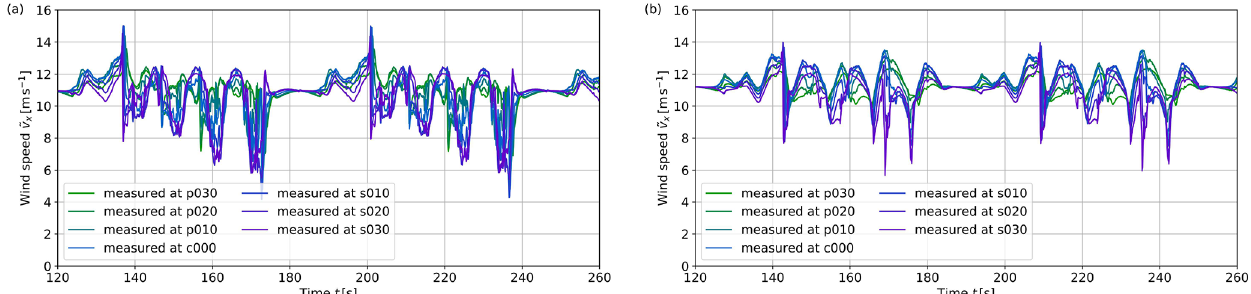
Figure 9. Instantaneous values of streamwise velocity (cid:101) v x measured at several locations along the wingspan for (a) lift-mode AWE system with original bounds and (b) lift-mode AWE system with induction-based limitation of reel-out speed. The prefixes “p” and “s” stand for the port and starboard sides of the wing, while the prefix “c” stands for the centre, i.e. the point mass. Furthermore, the numbers stand for the segment positions on each side of the wing, from 0 at the centre to 30 at the wing